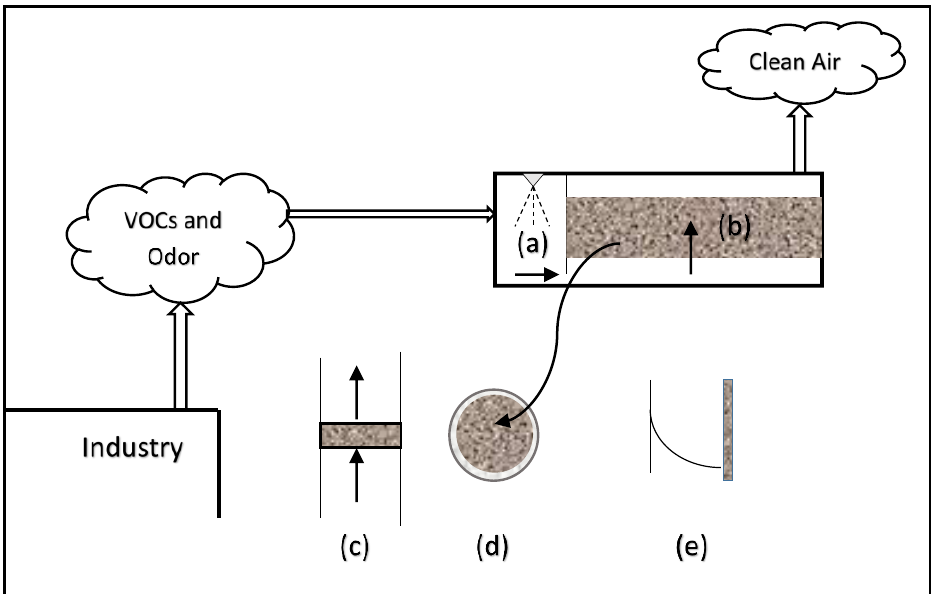
Figure 2. Gas-phase biofilter concept.